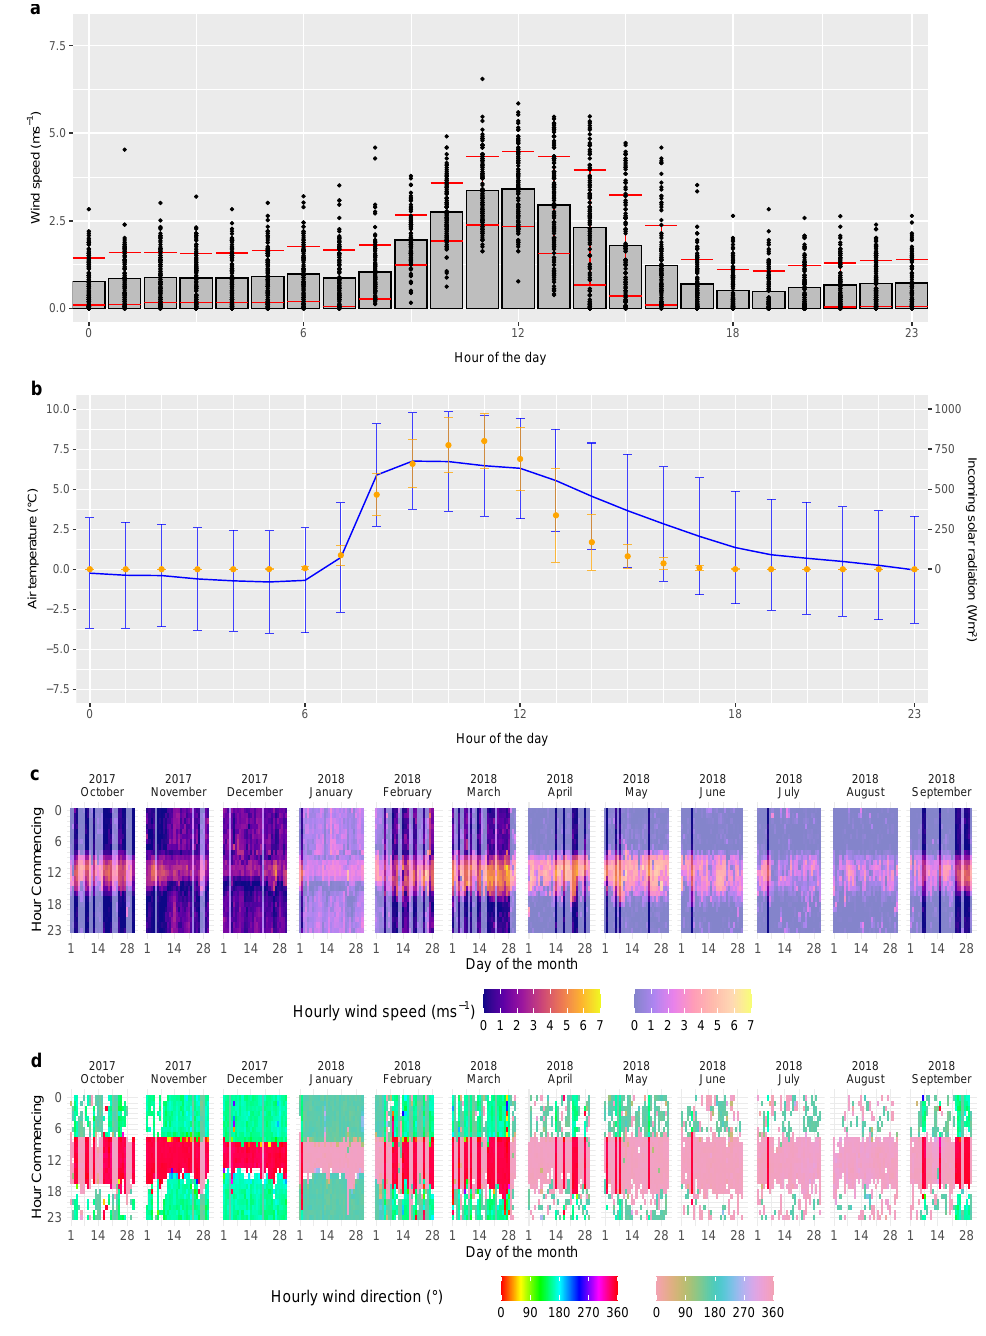
Figure 5. Wind speeds and direction during valley wind days at NE bottom station. Topmost position ( a ) shows the hourly mean value of wind speed on the VWD as bar height with the red SD whisker. Hourly data are provided as black dots. Plot ( b ) consists of the hourly means of temperature (blue) and mean incoming solar radiation sums (yellow) on the VWD. Whiskers of one SD are added to the parameters in the respective colors. Mean hourly wind speeds for every hour in the observational period are shown in ( c ). The bottom plot ( d ) shows hourly wind directions in the same period. Calm hours are shown as transparent boxes in ( d ). Both ( c ) and ( d ) show the VWD data with higher